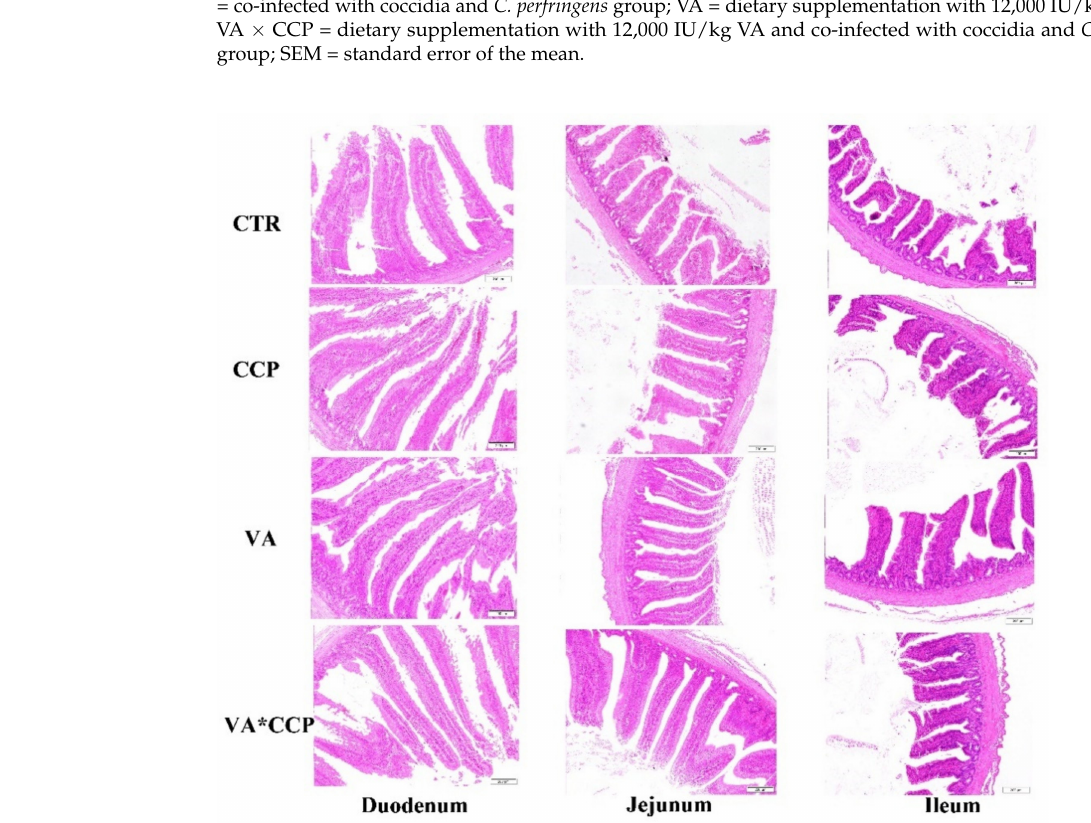
Figure 1. The intestinal morphological parameters on day 28. CTR = control group; CCP = co-infected with coccidia and C. perfringens group; VA = dietary supplementation with 12,000 IU/kg VA group; VA + CCP = dietary supplementation with 12,000 IU/kg VA and co-infected with coccidia and C. perfringens group. Each image has a 200 µ m scale, and the image is magnified 100 times. Table 10. Effect of vitamin A on intestinal morphology of broiler chickens co-infected with CCP on day